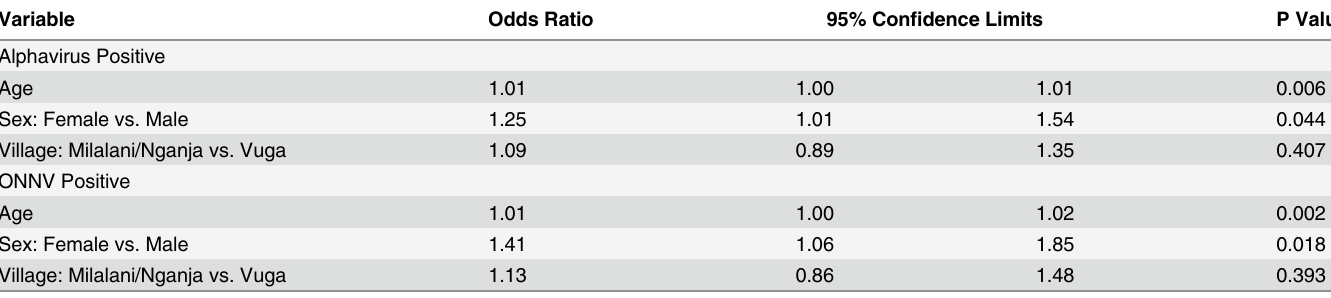
Table 2. Multivariate analysis of alphavirus seropositivity and ONNV-only seropositivity.